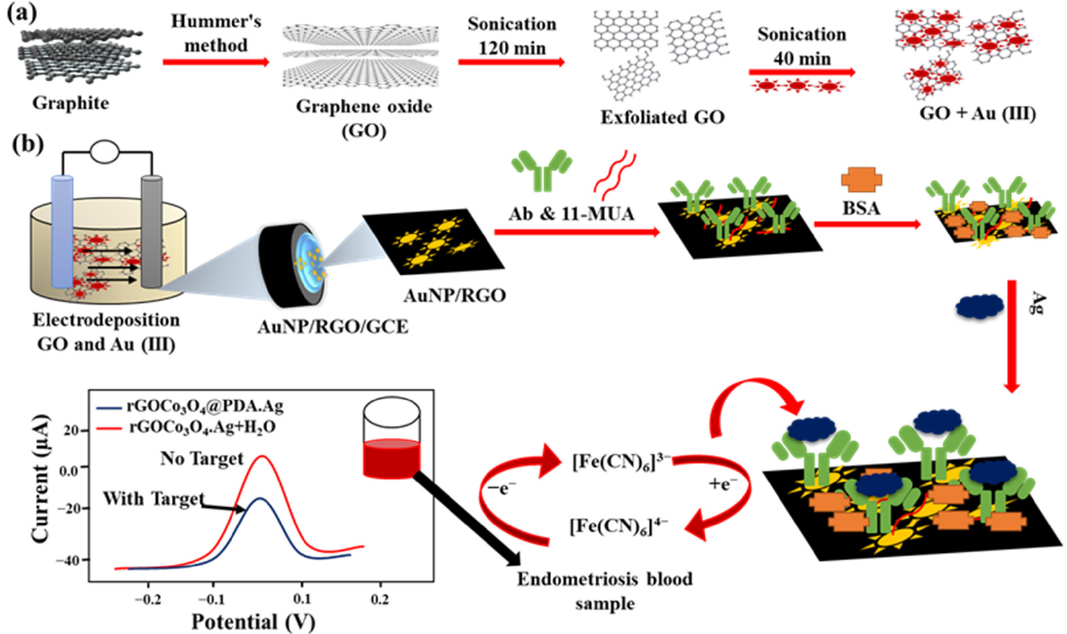
Figure 8. Showing the preparation and exfoliation of GO+Au 3+ in ( a ) and the fabrication of AuNPs/RGO/Ab/BSA/Ag/GCE and CA125 detection for endometriosis in ( b ). Redrawn from [93]. © ACS Publishing.